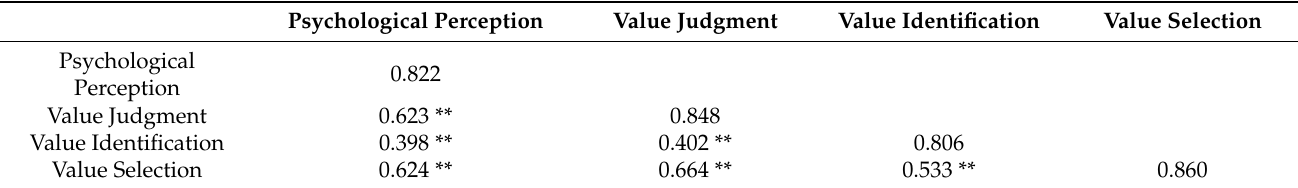
Table 5. Distinct Table 5. Distinct validity.